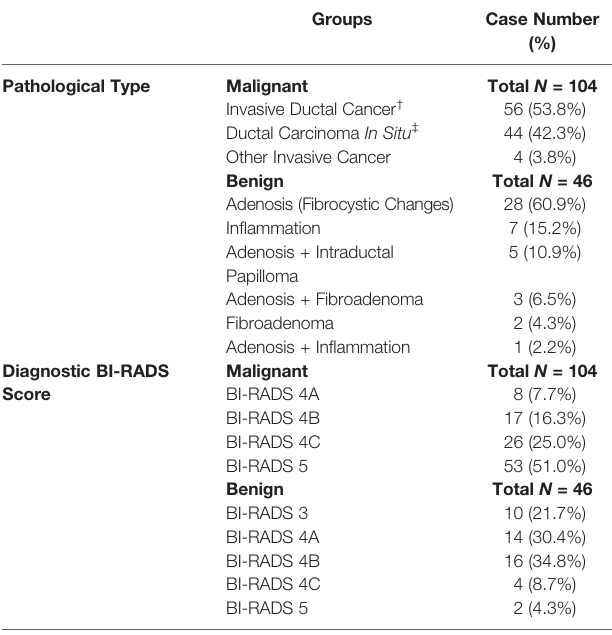
TABLE 1 | The pathological types and diagnostic BI-RADS scores in malignant and benign